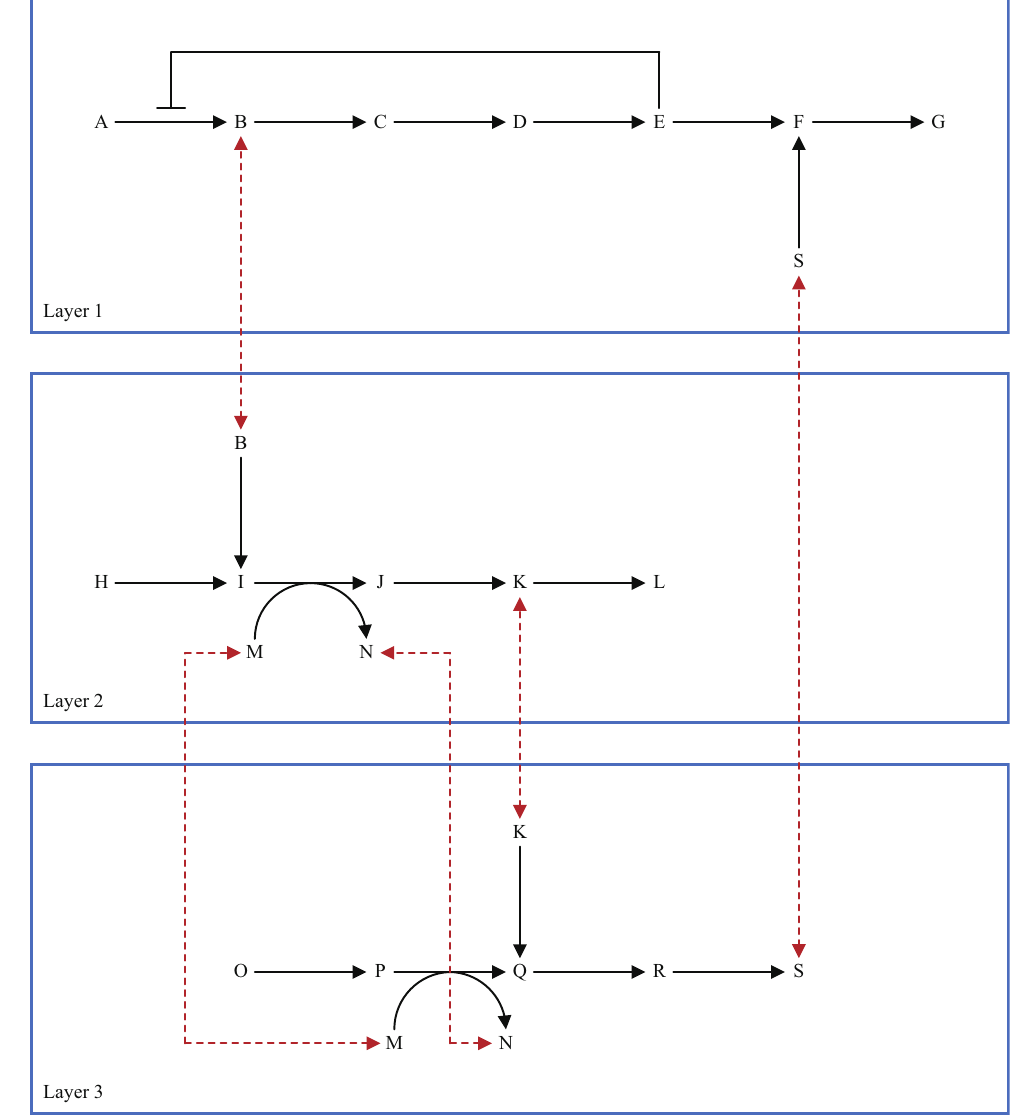
Figure 4. Example of the layer representation of the metabolic pathway shown in Figure 3. The red dashed lines indicate how each layer is connected through the reactants.